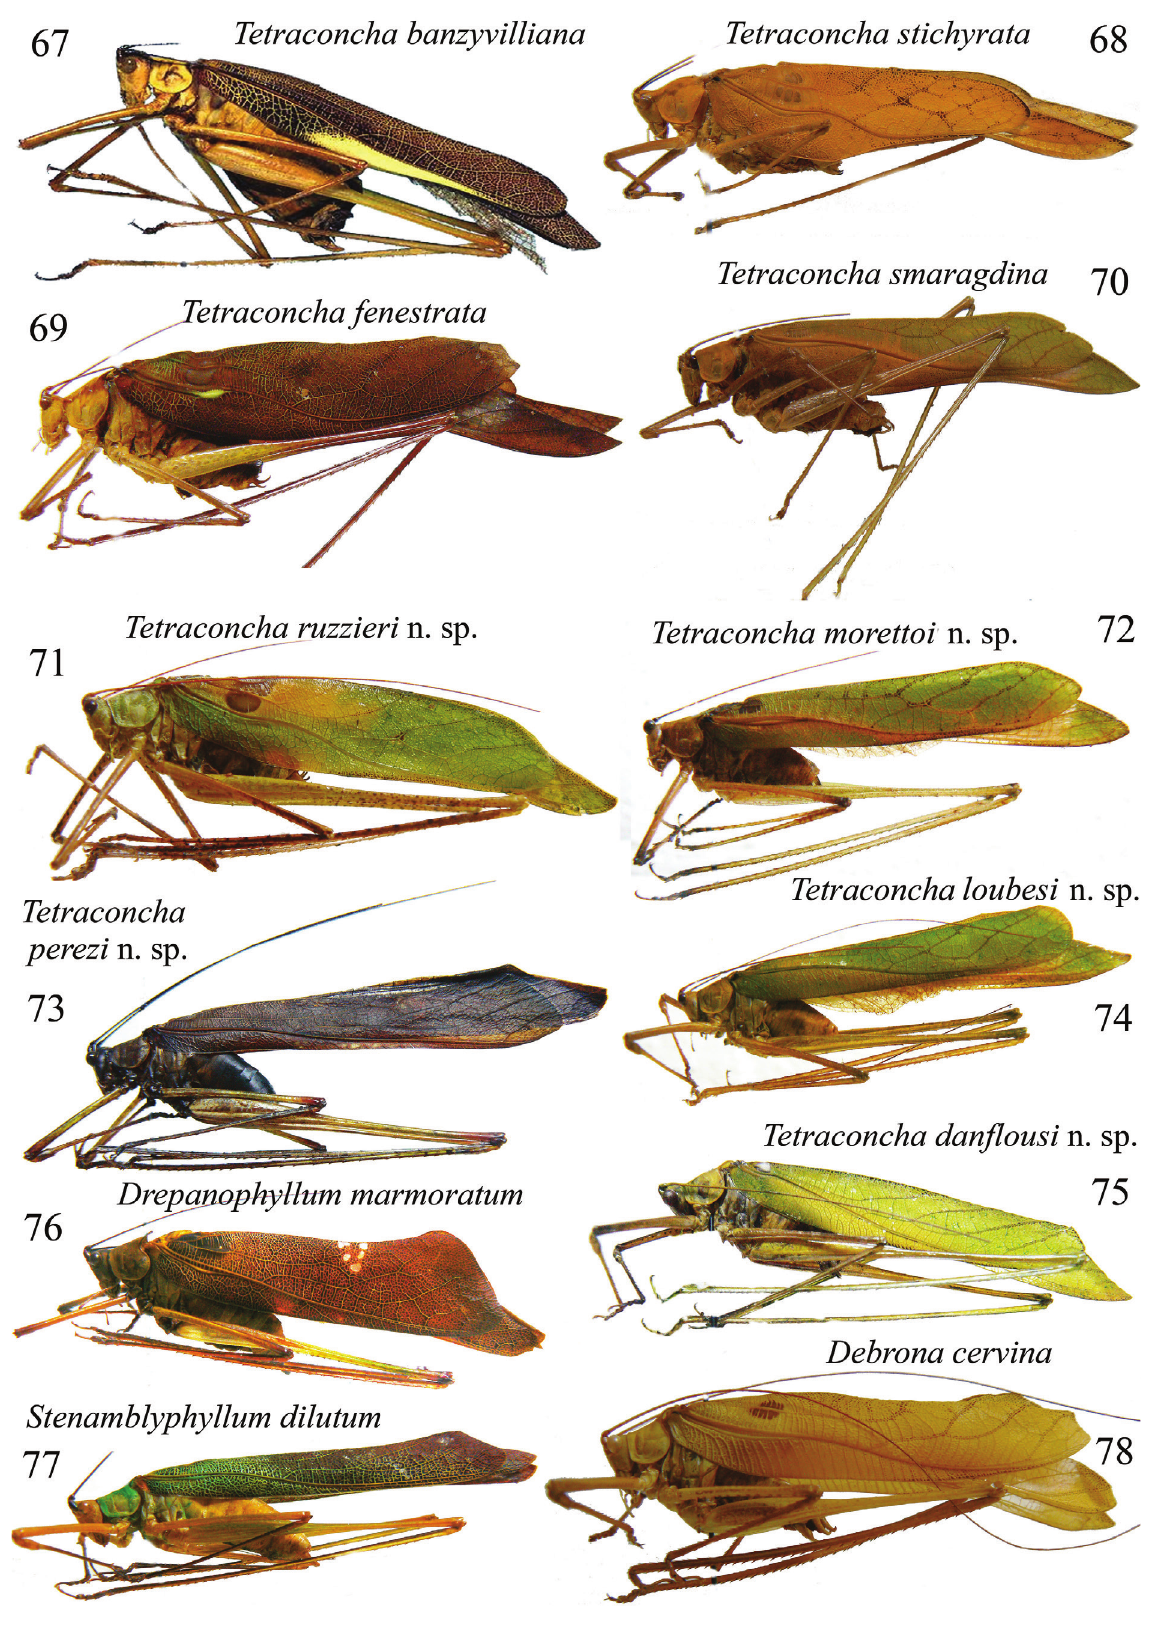
Figs 67–78. Habitus in lateral view of males of: 67. Tetraconcha banzyvilliana ; 68. T. stichyrata ; 69. T. fenestrata ; 70. T. smaragdina ; 71. T. ruzzieri sp. n.; 72. T. morettoi sp. n.; 73. T. perezi sp. n.; 74. T. loubesi sp. n.; 75. T. danflousi sp. n.; 76. Drepanophyllum marmoratum ; 77. Stenamblyphyllum dilutum ; 78. Debrona cervina